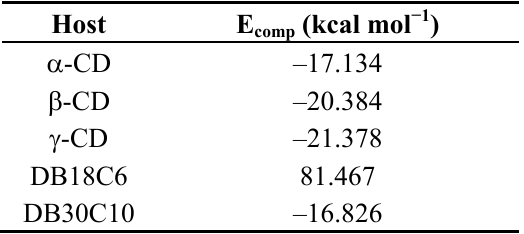
in kcal mol − 1 ) of the comp